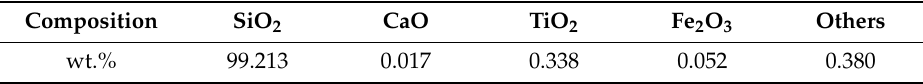
Table 2. Chemical compositions (wt.%) of porous